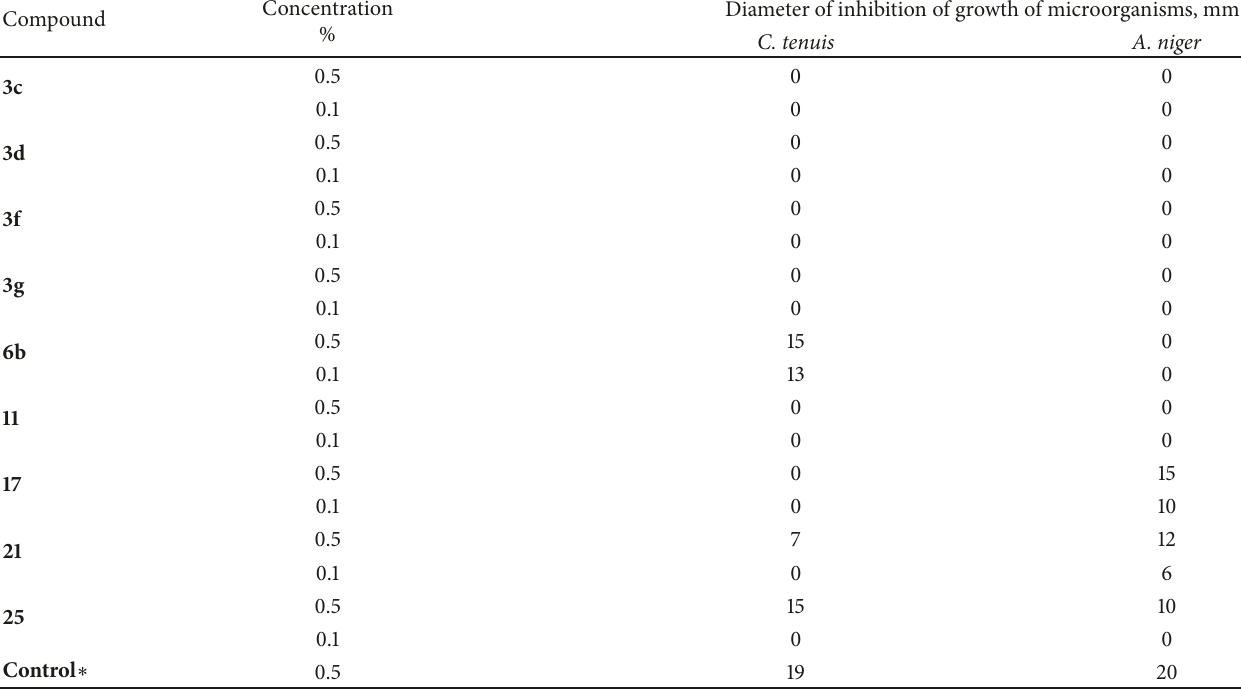
Table 2: Antifungal activity of the compounds determined by diffusion